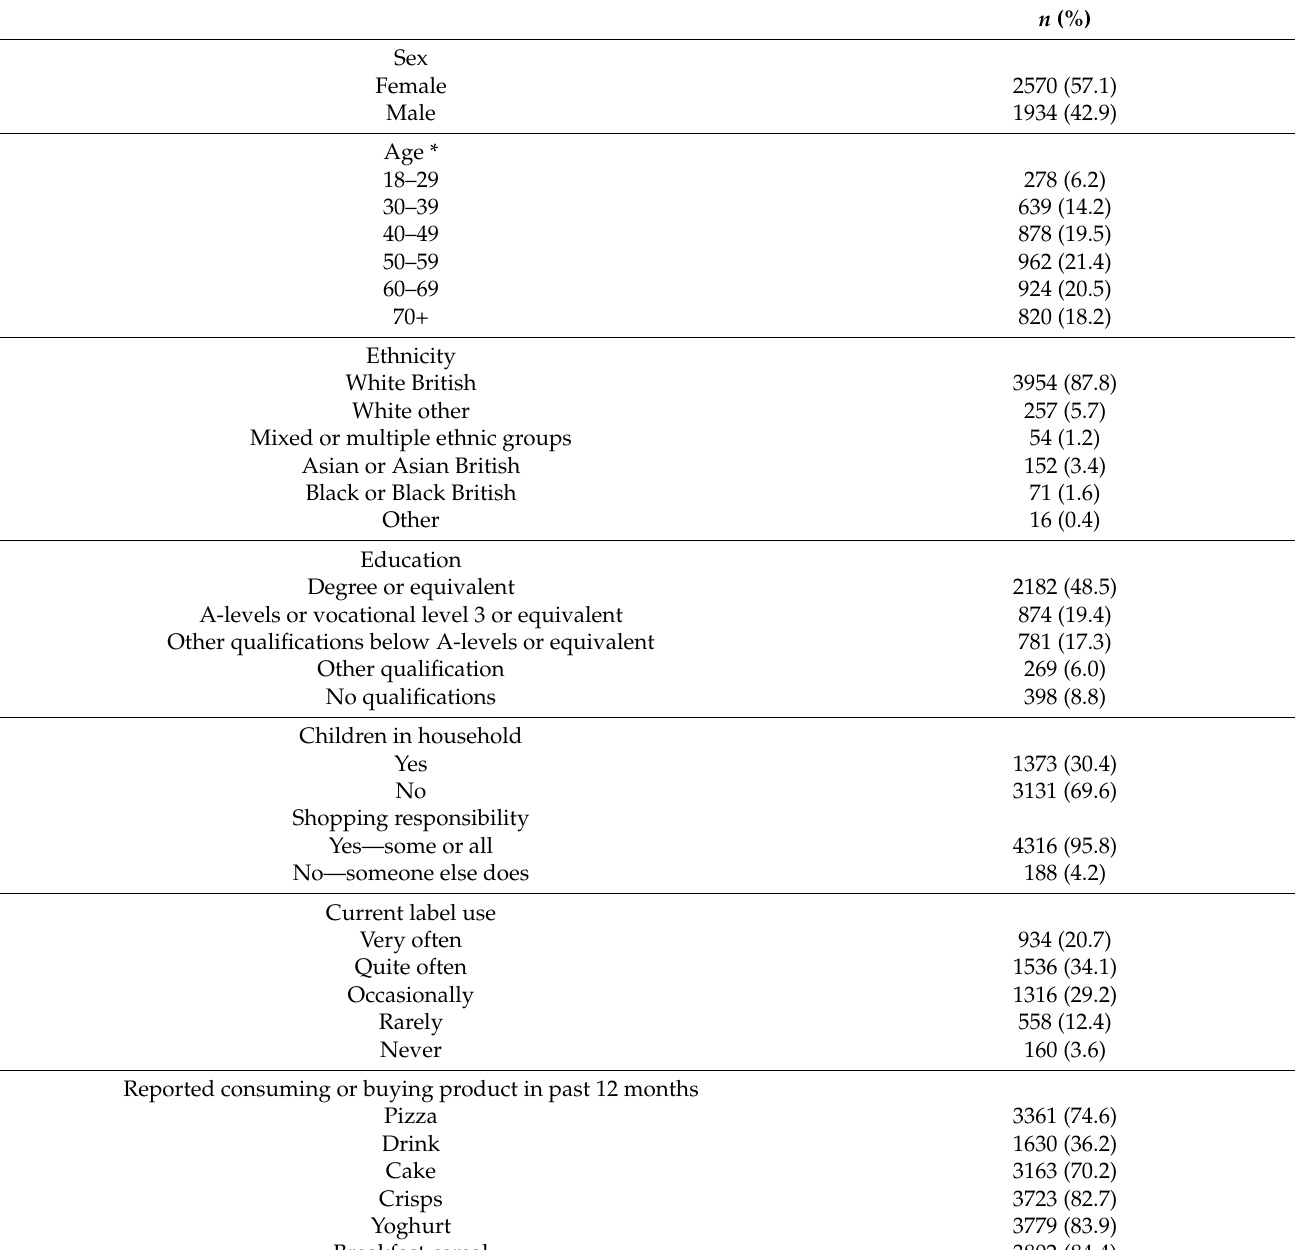
Table 1. Individual characteristics of the analysis sample ( n = 4504;